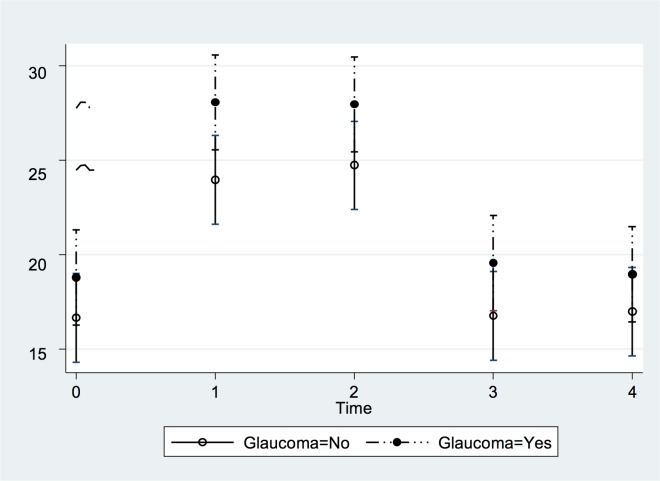
Least squares means and mean values of the covariates of the changes in IOP in the Uttanasana position over time.The X axis represents each time point an IOP measurement was taken (0 = Baseline seated; 1 = Immediate position; 2 = 2 minutes position; 3 = Post position seated; and 4 = 10 minutes post position seated). The Y axis represents the IOP in mmHg after adjusting for the covariates. Subjects with glaucoma diagnosis are depicted ‘Glaucoma = 1’; controls are ‘Glaucoma = 0’.